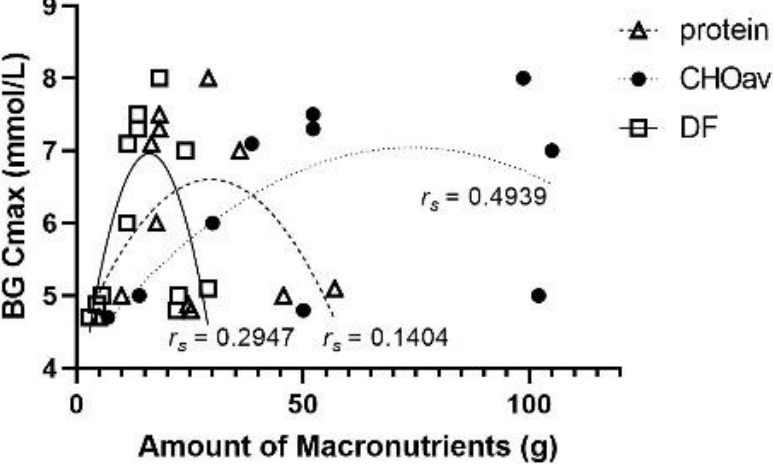
Figure 10. Maximum BG concentration (Cmax, mmol/L) according to the amount of macronutrients or dietary fibre (g) in the lentil treatments. Quadratic modeling best fit each component; protein ( r s = 0.1404; n = 12; ns ), dietary fibre (DF; r s = 0.2947; n = 12; ns ) and available carbohydrates (CHOav; r s = 0.4939; n = 10; ns ).